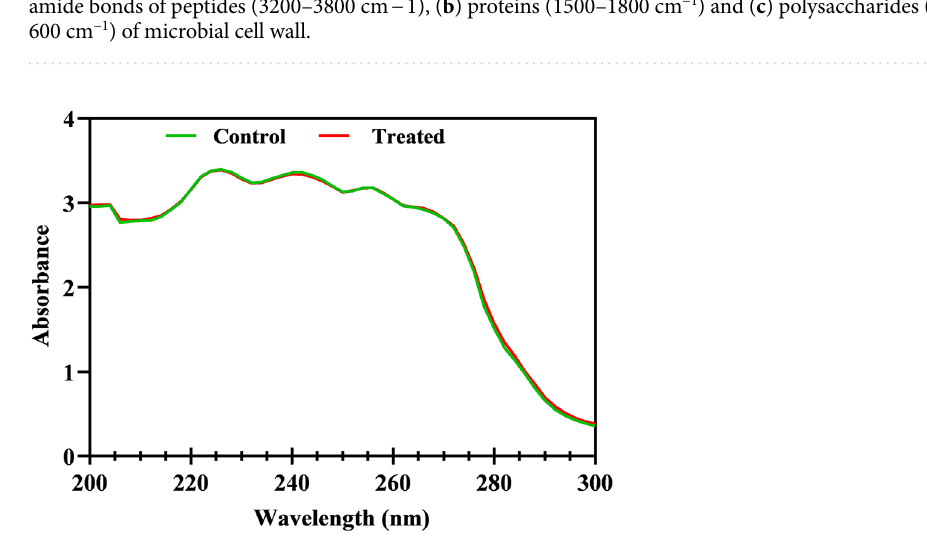
Figure 12. No, influence of catechol (at 256 µg/mL) on C. albicans ergosterol production after 24 h